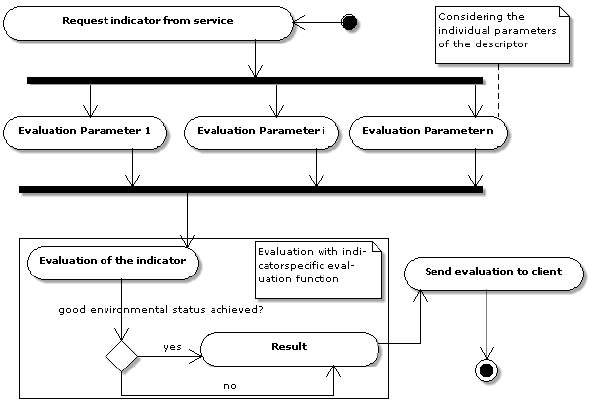
Figure 2. UML-activity diagram to evaluate an indicator